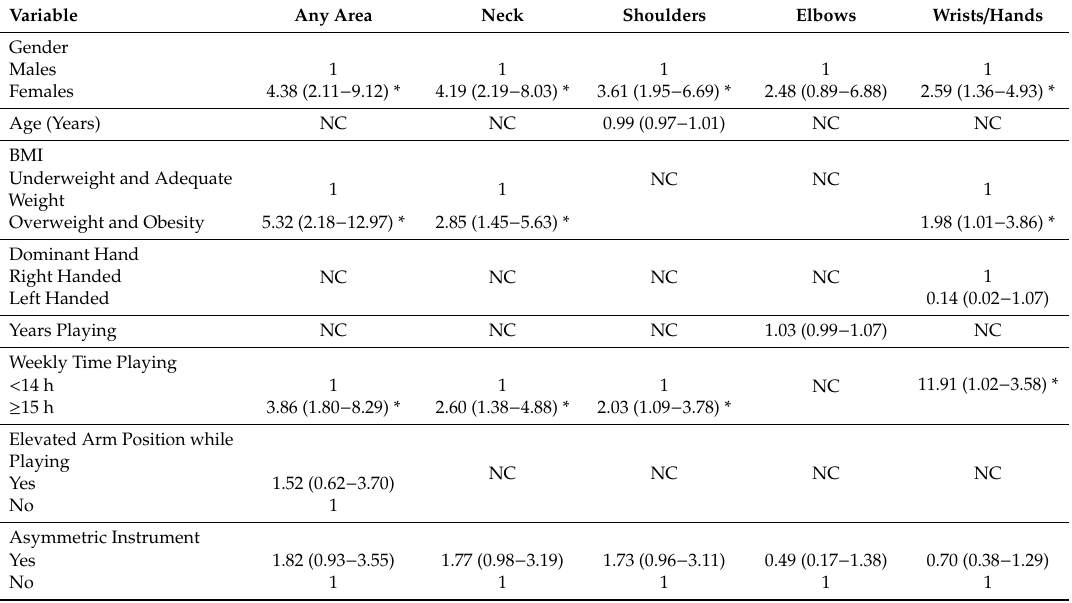
Table 7. Factors associated with pain in any area, neck, and upper